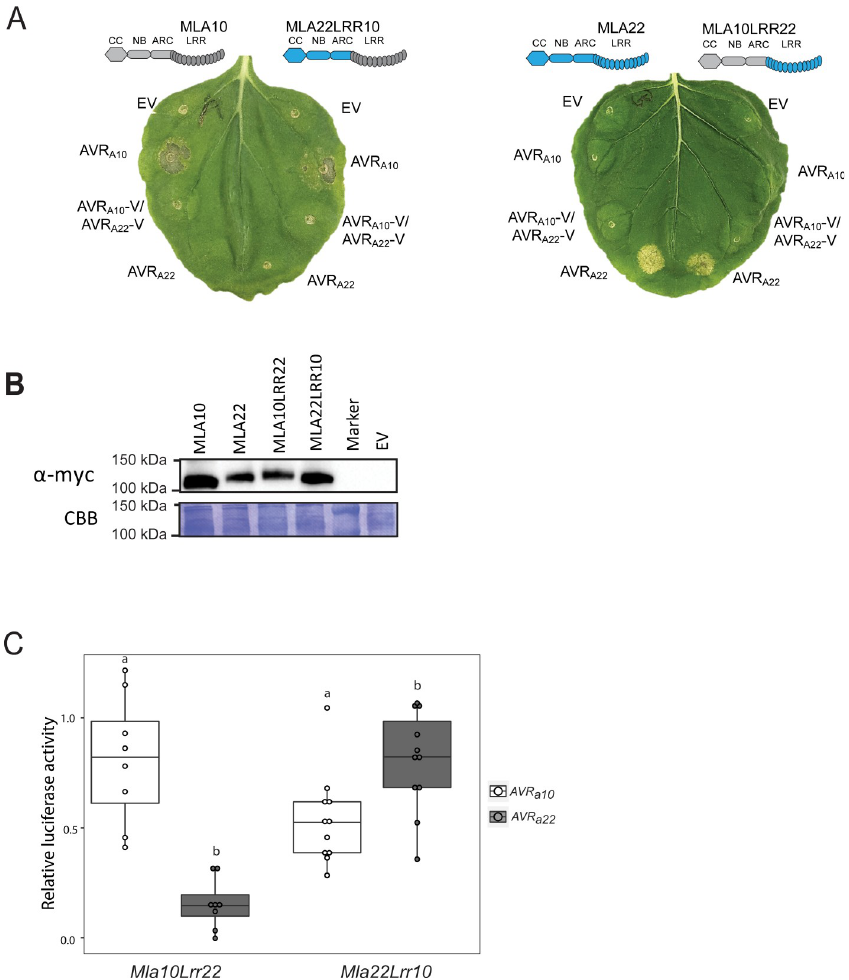
Fig 6. The LRR domains of MLA10 and MLA22 distinguish between AVR A10 and AVR A22 . (A) Transient transformation of Nicotiana benthamiana leaves with EV or cDNAs of AVR , and AVR a10 , AVR a10 -V/AVR a22 -V a22 fused C-terminally with mYFP together with Mla10 or Mla22 cDNAs fused C-terminally with a 4xmyc tag. All constructs were expressed from a 35S promotor. Cell death was scored five days post infiltration (dpi) and Figures show a representative of at least 15 co-transformations. (B) Protein levels of MLA-4xmyc after total protein extraction from N . benthamiana leaves at two dpi. Proteins were separated on a 10% polyacrylamide gel and a detected using α - myc western blotting (WB) (C) Barley cv . Golden Promise protoplasts were transfected with a LUC reporter construct and pIPKb002 vectors containing cDNAs of AVR a10 or AVR a22 together with Mla10Lrr22 and Mla22Lrr10 chimeras. Transfections were performed at least eight times independently. Significant differences between samples were analyzed using non-parametric Kruskal-Wallis (KW) one-way analysis of variance. Calculated KW p -values are as follows: Mla10Lrr22: p = 0.0007775; Mla22Lrr10: p = 0.01654. Samples labeled with different letters differed significantly ( p <